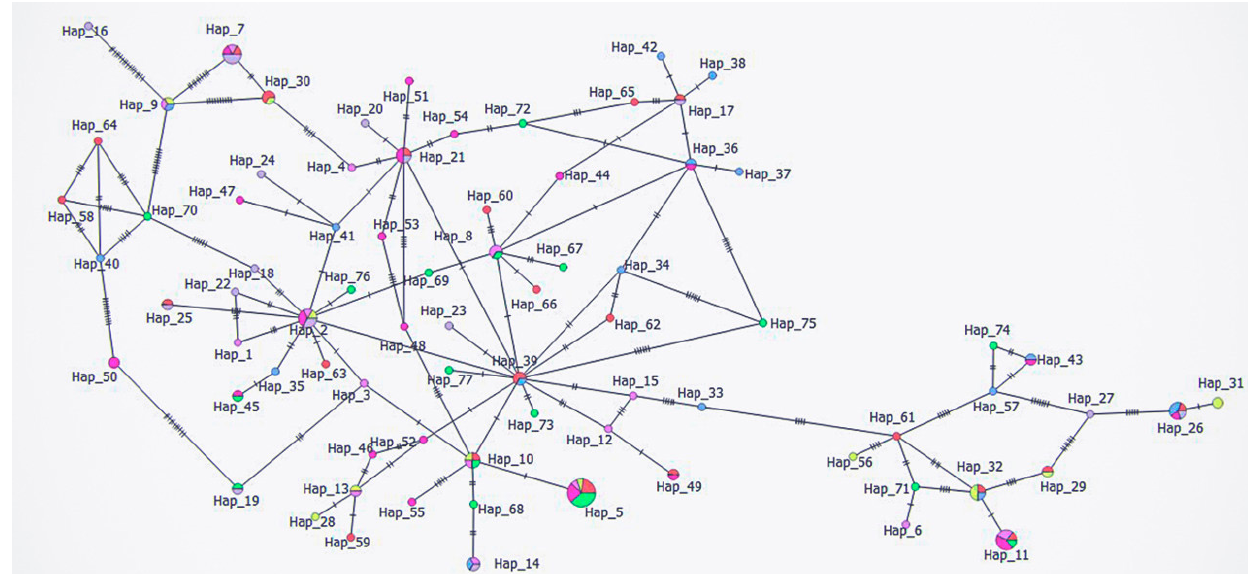
FIGURE 3 | Median-joining network of Prochilodus lineatus , based on haplotypes of D-loop marker. Sizes of the circled are proportional to the frequencies of the haplotypes at issue. The colors indicate the groups according to the collections: red circles: Sep_03; yellow circles: Jan_05; purple circles: Aug_05; blue circles: Jan_06; pink circles: Jan_09; green circles: Sep_10; pastel pink circles: Feb_15. Hatch marks represent the number of mutations by which haplotypes differ.